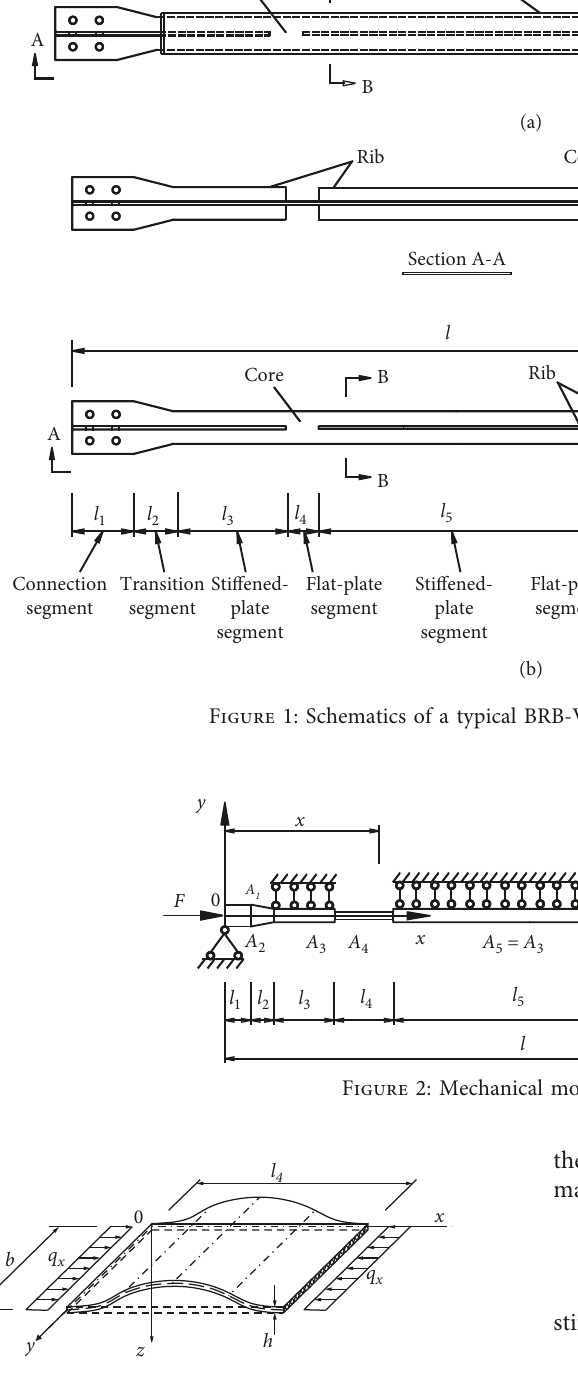
Figure 3: Buckling of the flat-plate